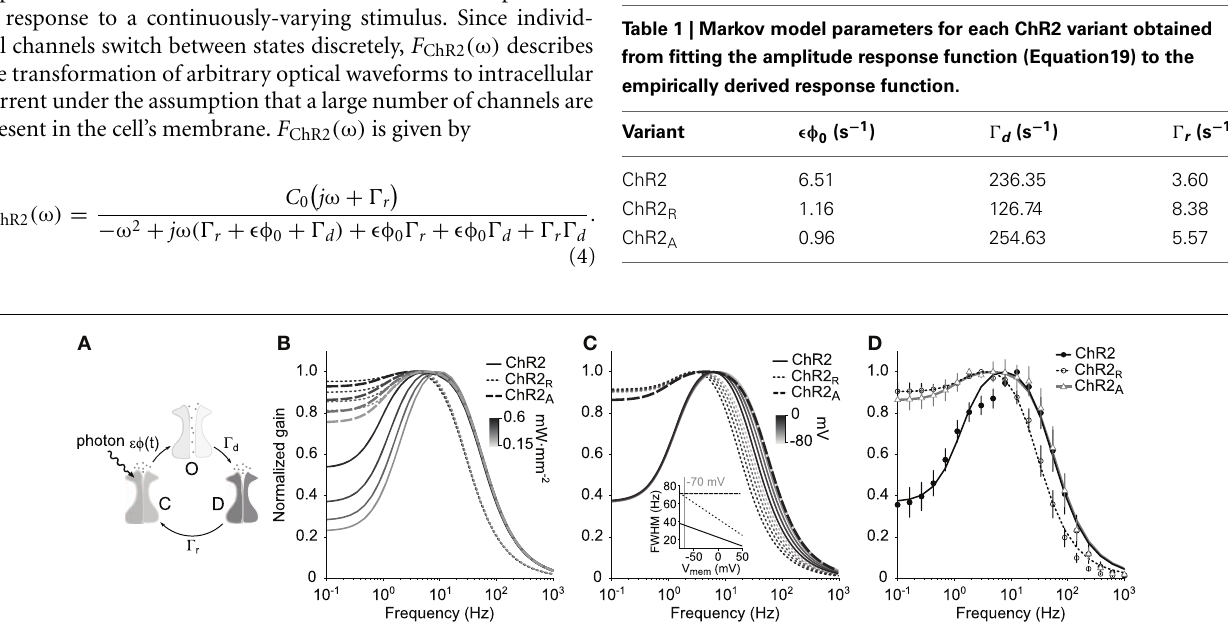
FIGURE 1 | ChR2’s amplitude response function. (A) Illustration of the three-state Markov channel model described by Equations 1–3. The transition rates between open, O , desensitized, D , and closed, C , states are (cid:3)φ ( t ) , (cid:2) r , and (cid:2) d , respectively. (B) Amplitude response functions ( 2 π f ) | for the model are shown for three ChR2 variants using | F ChR2 different mean illumination intensities (0.15–0.6mW · mm − 2 ) and parameters in Table 1 . (C) Voltage dependence of ChR2’s amplitude